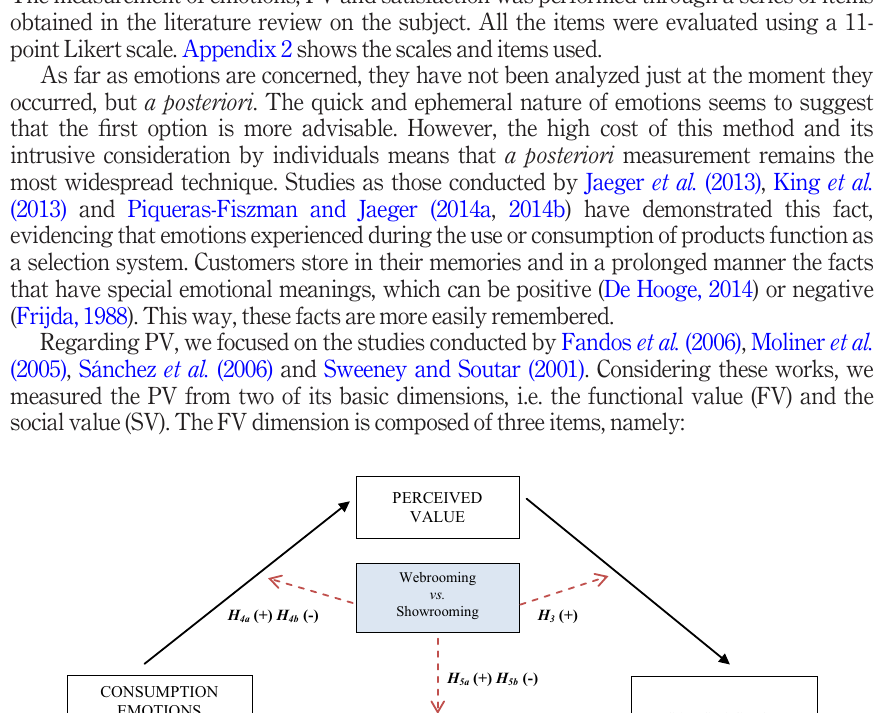
Figure 2. Research proposal